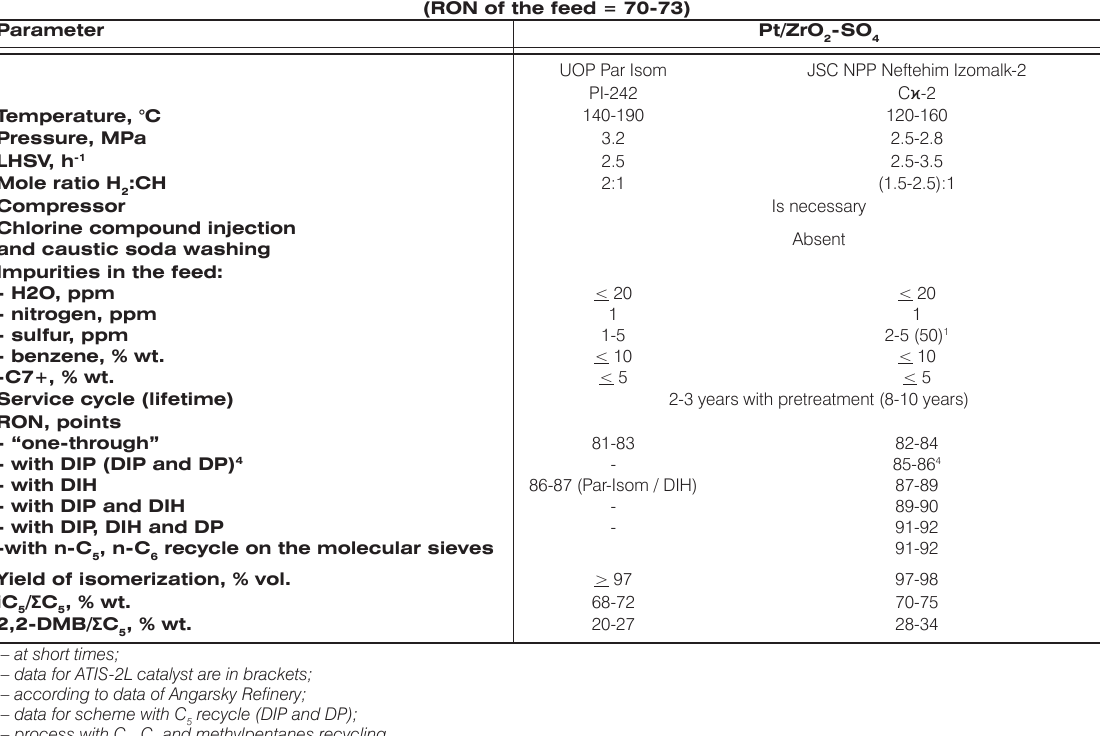
Table 1c. Performances of sulfated zirconia catalysts, yields, obtained Research Octane Numbers [21]. Performances of UOP, Axens, Süd Chemie and JSC „NPP Neftehim“ isomerization technologies (RON of the feed =